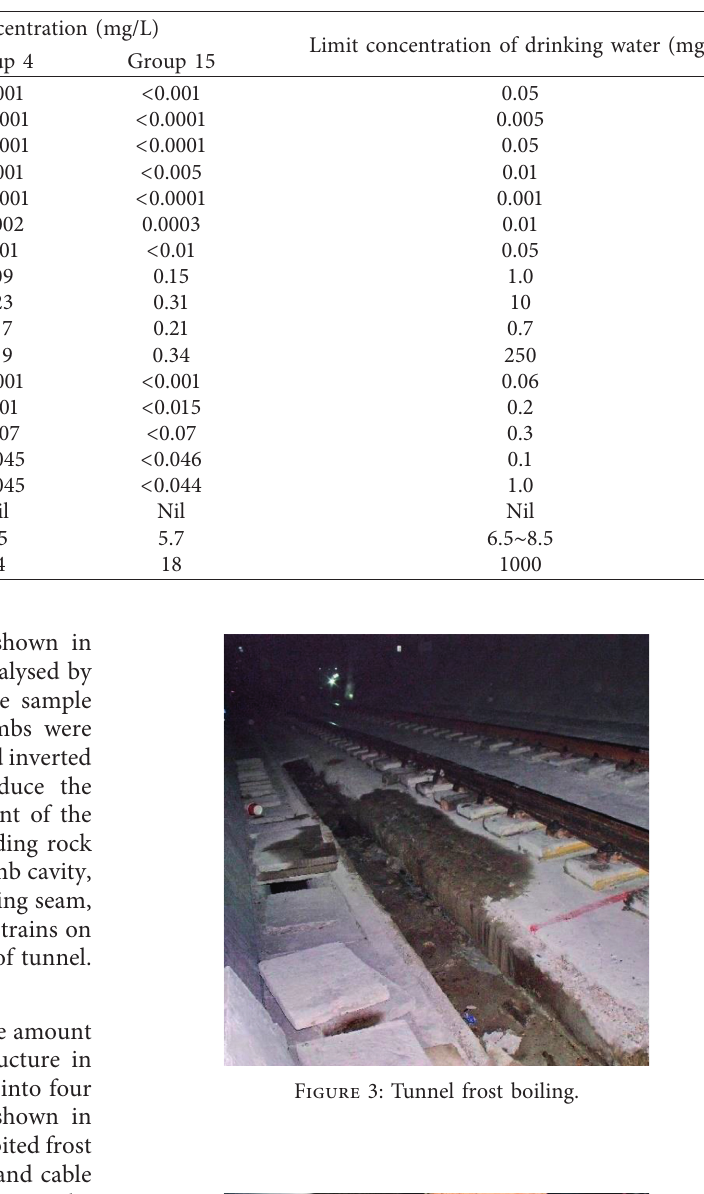
Table 9: Detection results of ion concentration in aqueous solution.